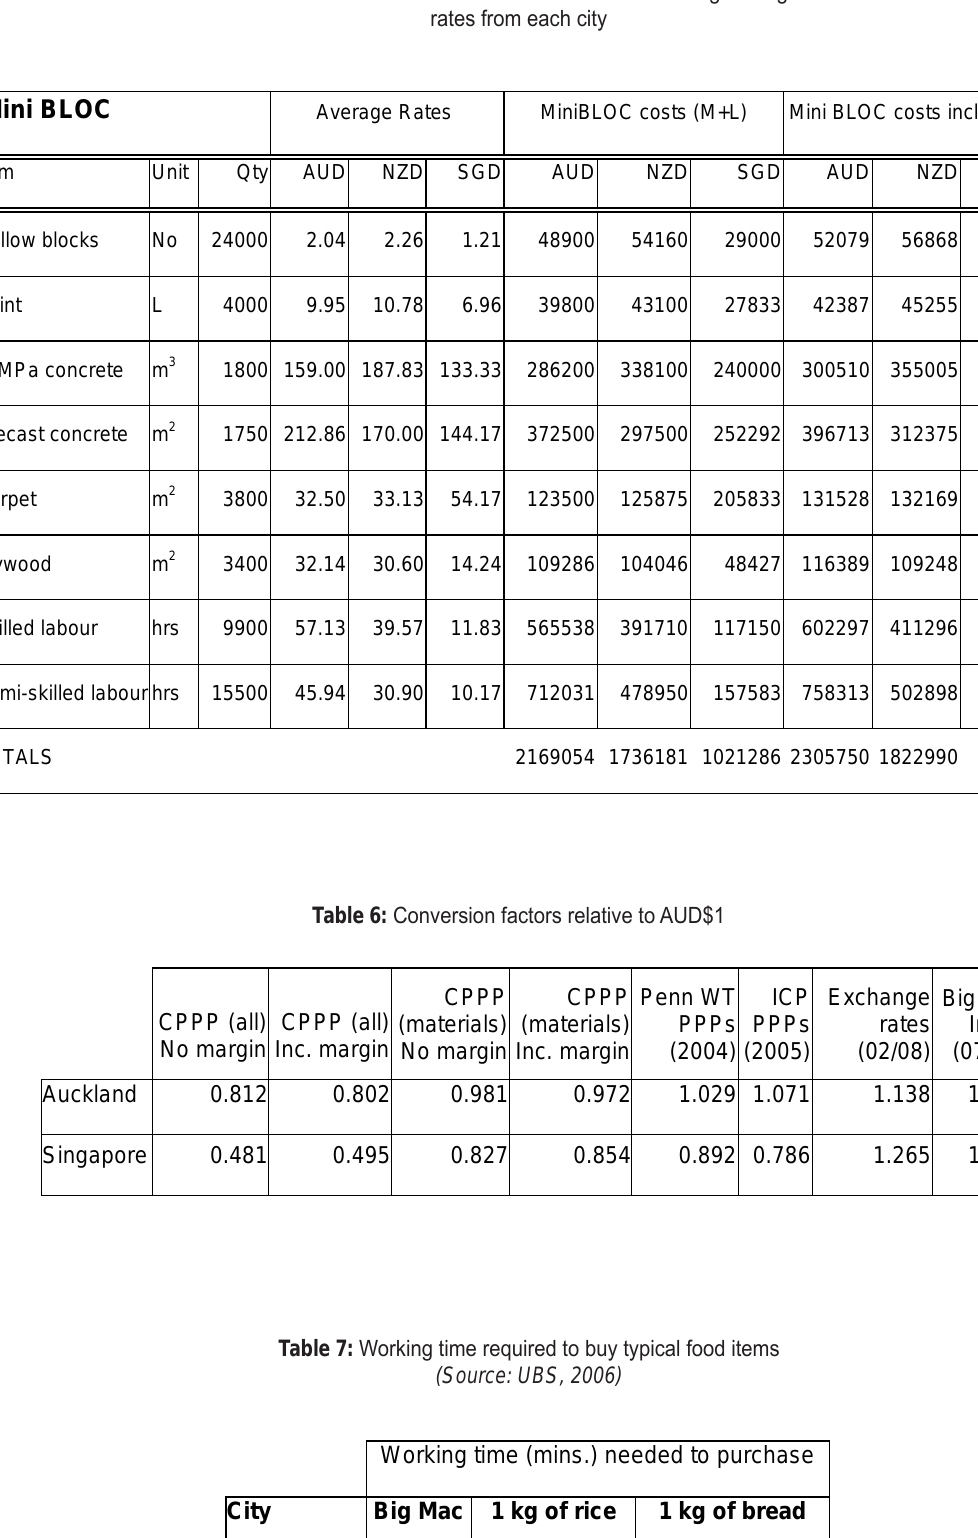
Table 5: Costs for the basket in local currencies using average